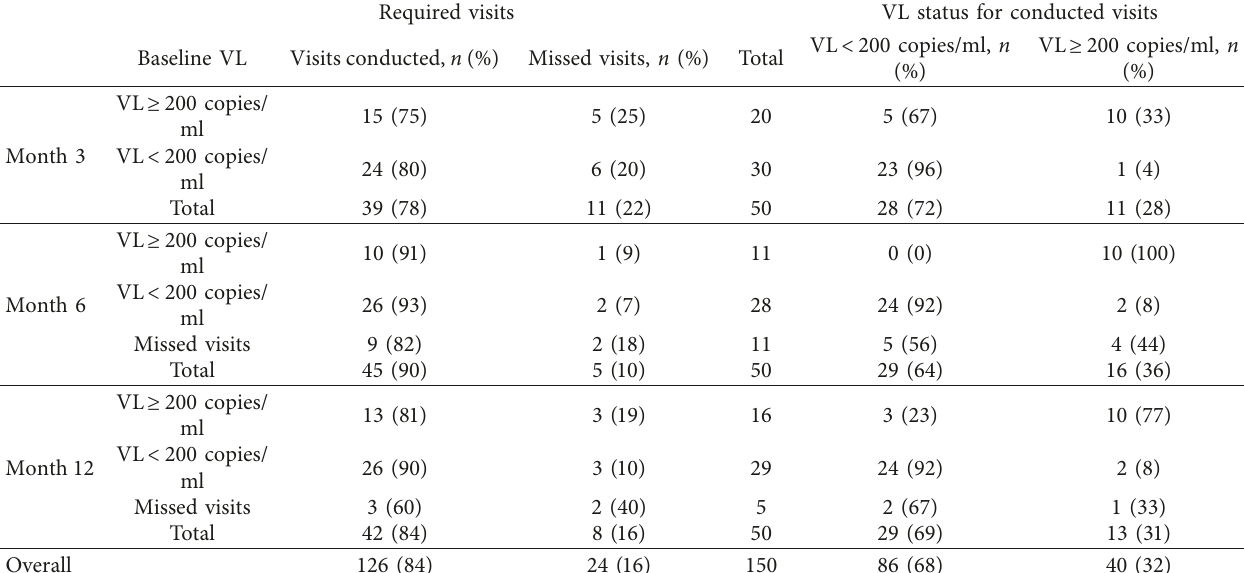
Table 6: Viral suppression based on VL visit attendance. Required visits VL status for conducted visits Baseline VL